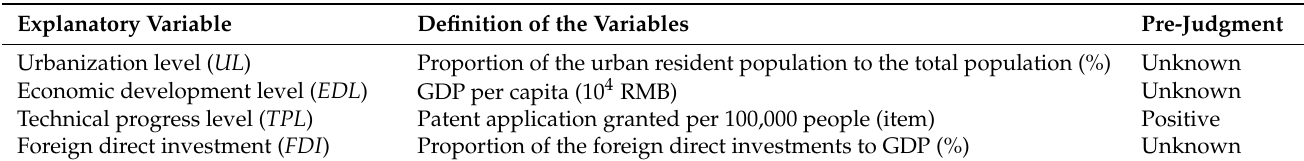
Table 2. Influencing